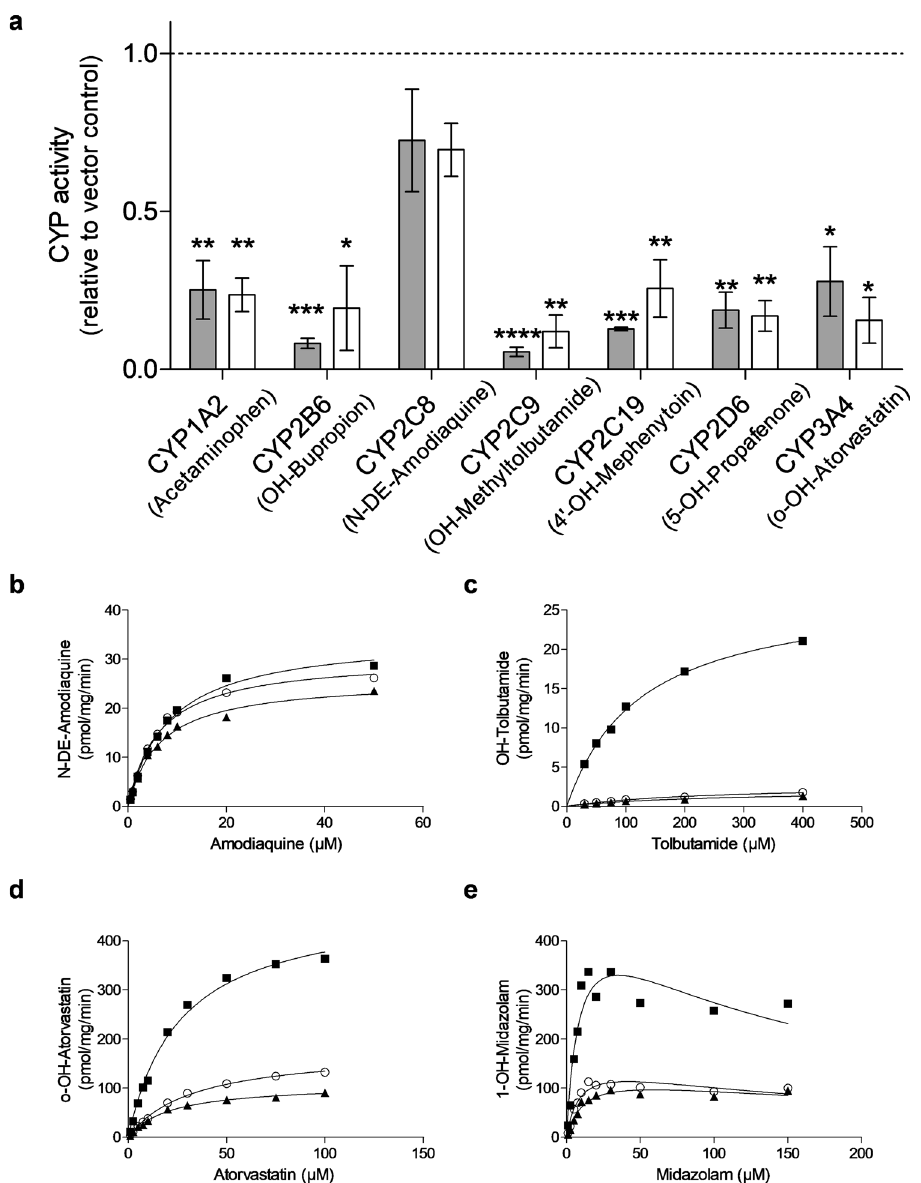
Figure 3. CYP activities in microsomal fractions of HepaRG -POR cells. ( a ) HepaRG cells transduced with sgRNA POR#1 (grey) or POR#2 (white) were differentiated for 3 weeks and harvested for microsome preparation. Enzyme activities of seven CYP enzymes were determined simultaneously by cocktail LC–MS/ MS assay and given relative to HepaRG VC . Results are shown as means ± SD of four independent experiments. Statistical significance unpaired t-test (* p < 0.05, ** p < 0.01, *** p < 0.001, **** p < 0.0001). ( b-e ) Kinetic analysis of selected substrate conversions in HepaRG microsomes. HepaRG cells transduced with vector control (VC, filled square), sgRNAs POR#1 (filled triangle) and POR#2 (open circle) were differentiated for 3 weeks and harvested for microsome preparation; ( b ) amodiaquine (CYP2C8); ( c ) tolbutamide (CYP2C9); ( d ) atorvastatin (CYP3A4); ( e ) midazolam (CYP3A4). Data were analyzed by Michaelis–Menten model ( b – d ) or by substrate inhibition model ( e